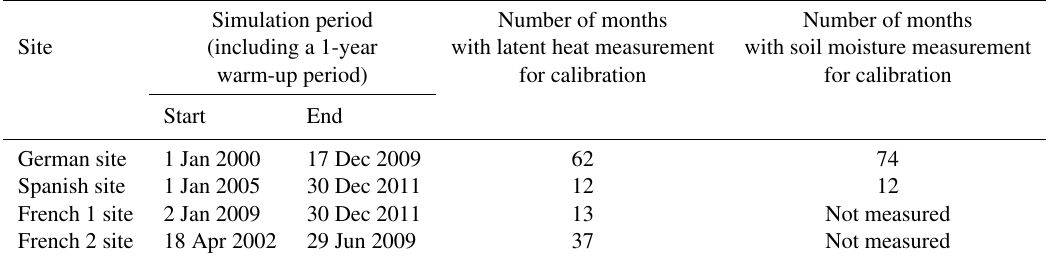
Table 2. Simulation period at the four FLUXNET sites, and number of months for which latent heat measurements and soil moisture measurements are available to calibrate the model. Soil moisture measurements are not provided at the two French